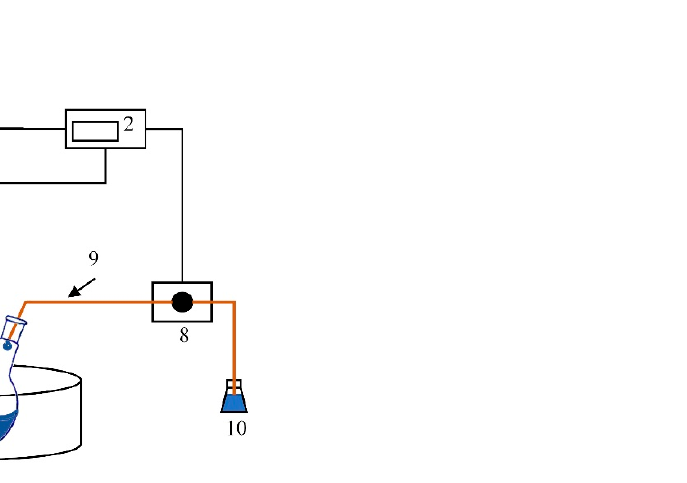
Figure 2. Schematic diagram of the redox potential controlling device: ( 1 ) host computer, ( 2 ) microcontroller, ( 3 ) analog to digital converter (ADC), ( 4 ) redox potential composite electrode, ( 5 ) stirrer, ( 6 ) four-hole boiling flask, ( 7 ) water bath heater, ( 8 ) peristaltic pump, ( 9 ) rubber tube, ( 10 ) redox potential regulator.